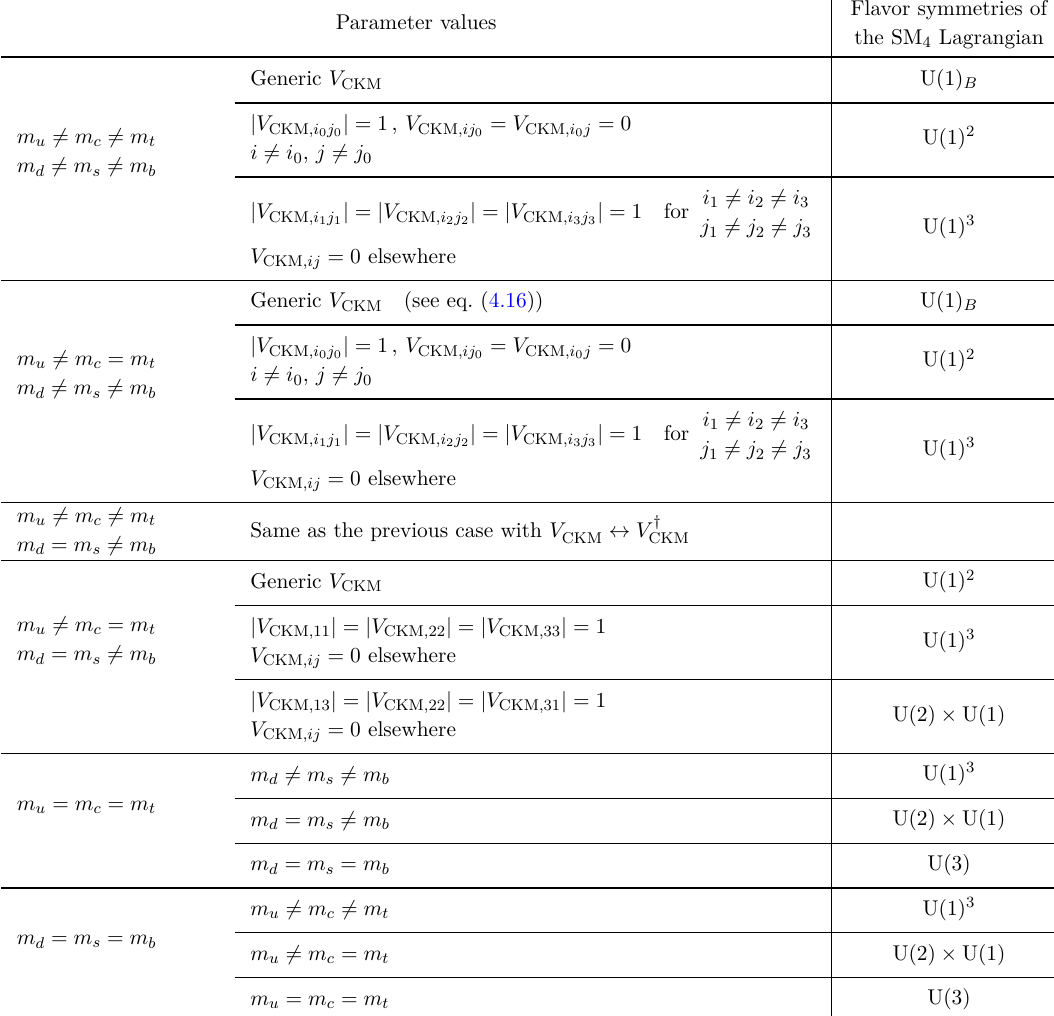
Table 3 . Flavor symmetry of the SM 4 Lagrangian as a function of special values for quark masses (assumed to be non-vanishing, see appendix A for the general case) and entries of the CKM matrix. Conditions on the right are understood to be imposed on top of those on their left. Here only some of the possible combinations of mass degeneracies are treated. The other mass degeneracies lead to the same flavor symmetries provided the corresponding non-generic V CKM are multiplied by appropriate matrices exchanging flavor labels (see footnote